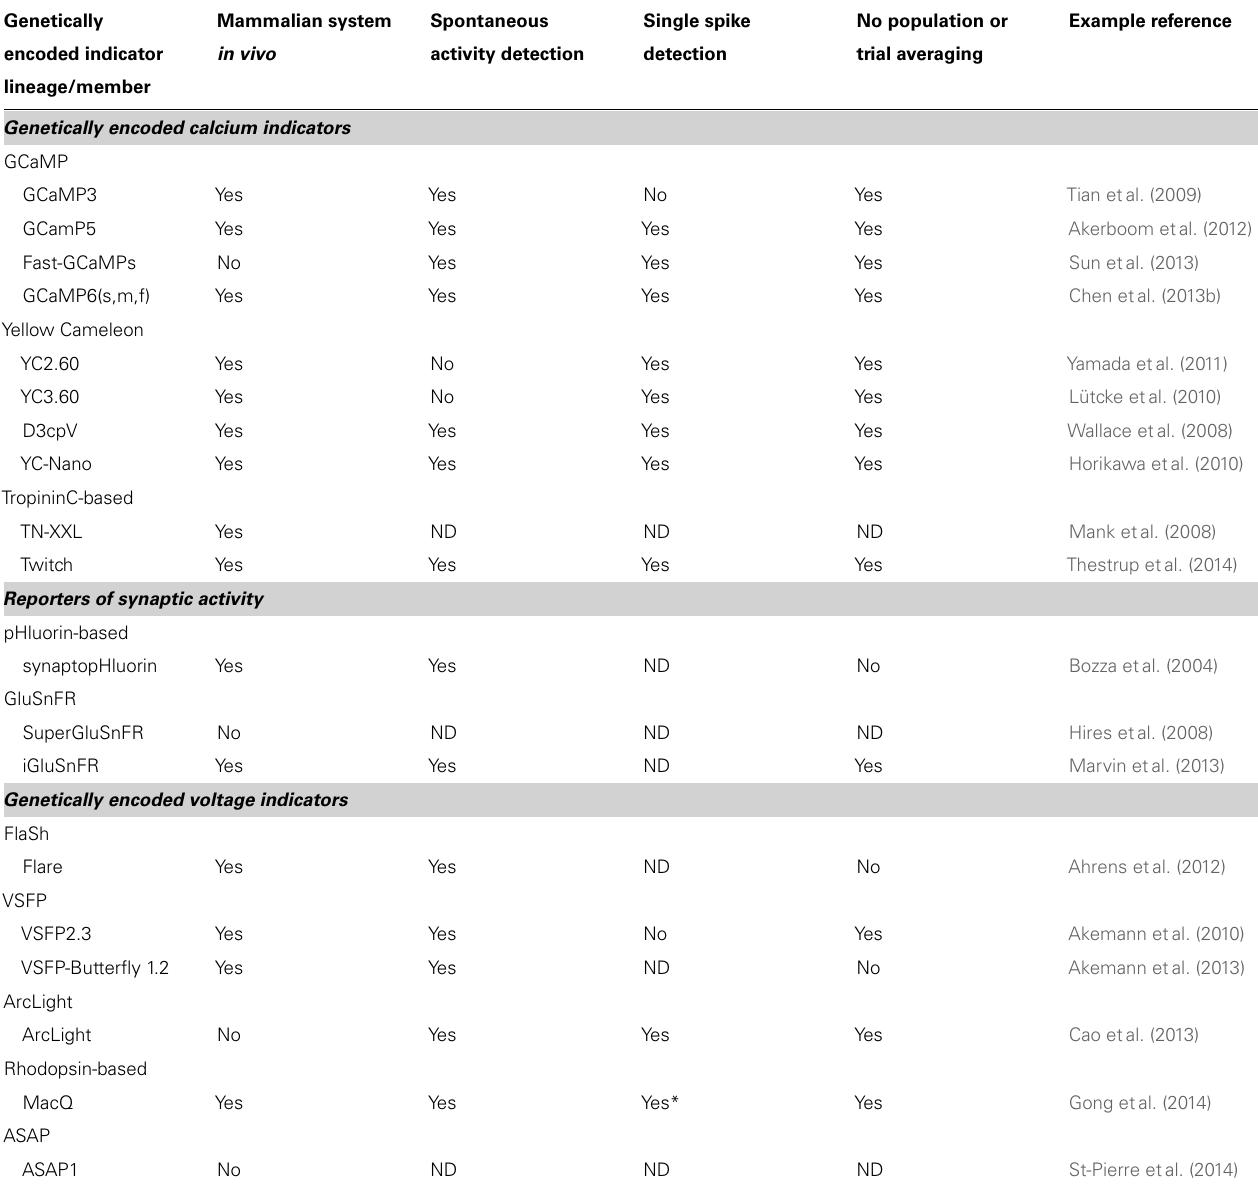
Table 1 | Selected examples of modern genetically encoded indicators and their degree of utility in in vivo imaging in the mammalian brain. Genetically